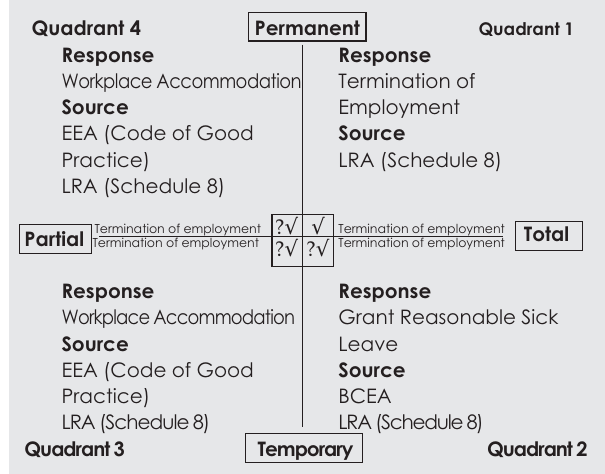
Fig. 1. Managing impairment integrated model —